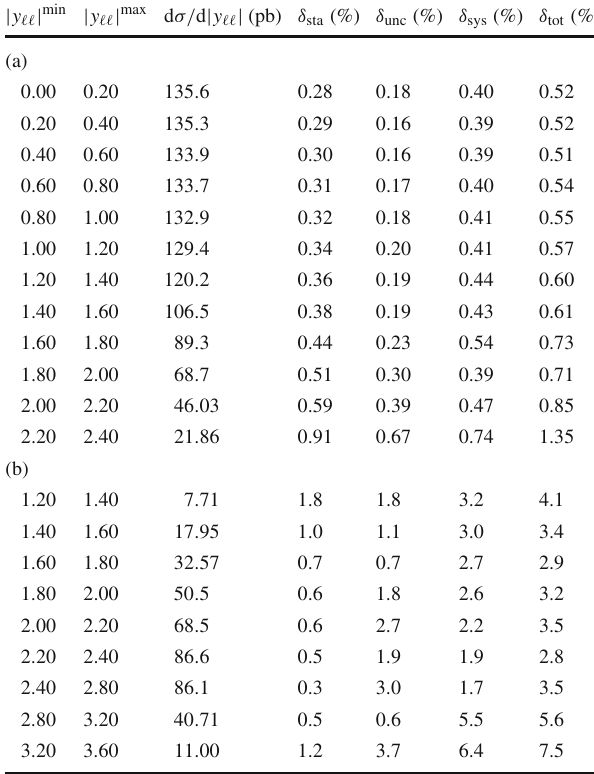
Table 25 Differential cross section for the Z /γ ∗ → e + e − process in the central (a) and forward (b) region with 66 < m (cid:3)(cid:3) < 116 GeV, extrapolatedtothecommonfiducialregion.Therelativestatistical( δ sta ), uncorrelated systematic ( δ unc ), correlated systematic ( δ sys ), and total ( δ tot ) uncertainties are given in percent. The overall 1 . 8% luminosity uncertainty is not included